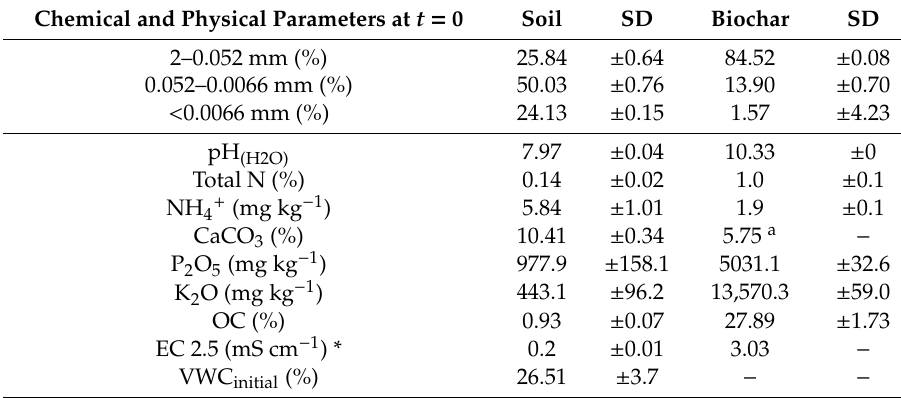
Table1. Physicalandchemicalcharacteristicsofthesoilandbiocharusedatthebeginningoftheexperiment. n = 3; mean ± standard deviation (SD). VWC represents volumetric water content, OC represents organic carbon content, EC represents the electrical conductivity. Part of the data was adapted from Pokovai et al. [8]. a Data were estimated from a different study using the same biochar type [36]. Chemical and Physical Parameters at t = 0 Soil SD